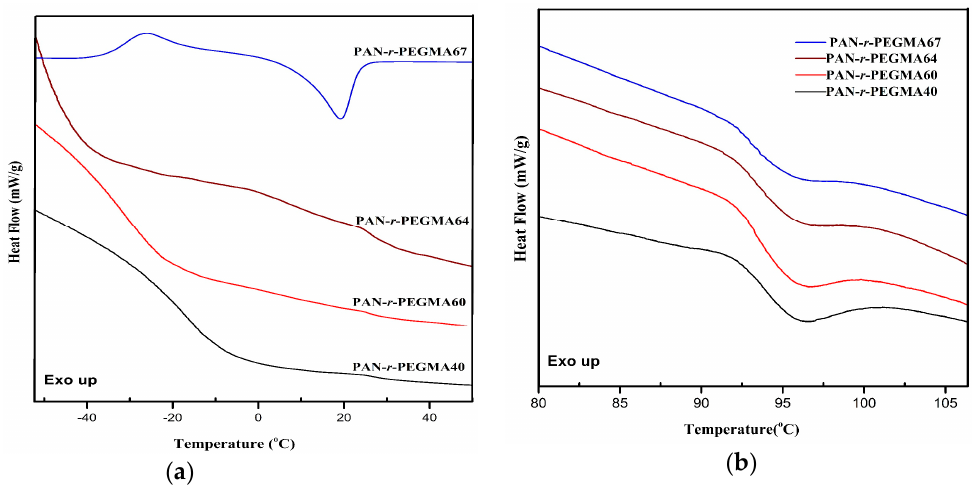
Figure 4. ( a , b ) The differential scanning calorimetry thermograms for PAN- r -PEGMA copolymers.